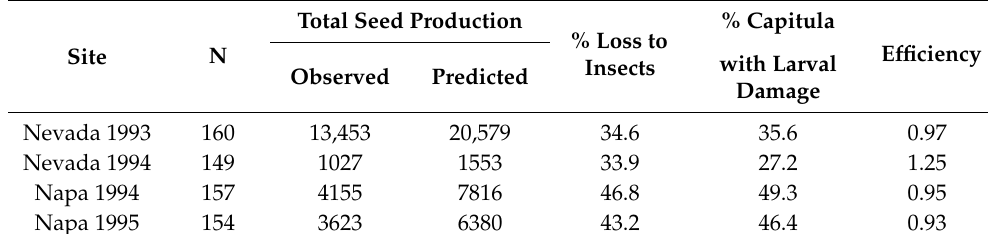
Table 8. Observed (with Eustenopus villosus ) and predicted (without E. villosus ) seed production and percent seed loss for transect plants at study sites from 1993 to 1995. N = number of plants sampled. Efficiency is the ratio of % seed loss to % capitula with larval damage.